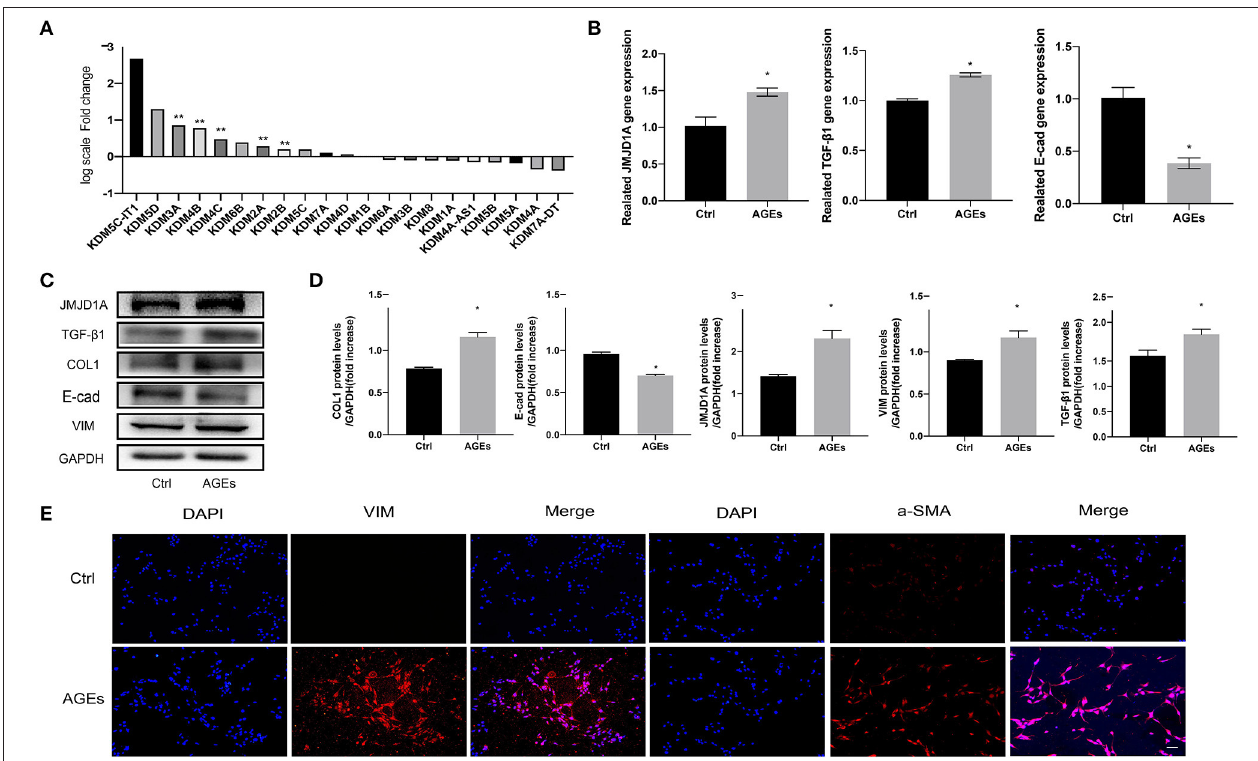
FIGURE 4 | JMJD1A may be an epigenetic regulator of AGEs-induced fibrosis in HK-2 cells. (A) Quantitative gene expression changes in JMJD families detected by RNA sequencing ( n = 3, ** p < 0.001). (B) HK-2 cells were stimulated with 400 µ g/ml AGEs for 72h, and the expression of JMJD1A, TGF- β 1, and E-cad was detected by RT-qPCR ( n = 3, * p < 0.05). (C,D) Western blot was used to detect the expression of fibrosis-related factors (JMJD1A, TGF- β 1, COL1, E-cad, VIM) in HK-2 ( n = 3, * p < 0.05). (E) Immunofluorescence was used to detect the expression of fibrosis-related factors a-SMA and VIM (scale bar, 100 µ